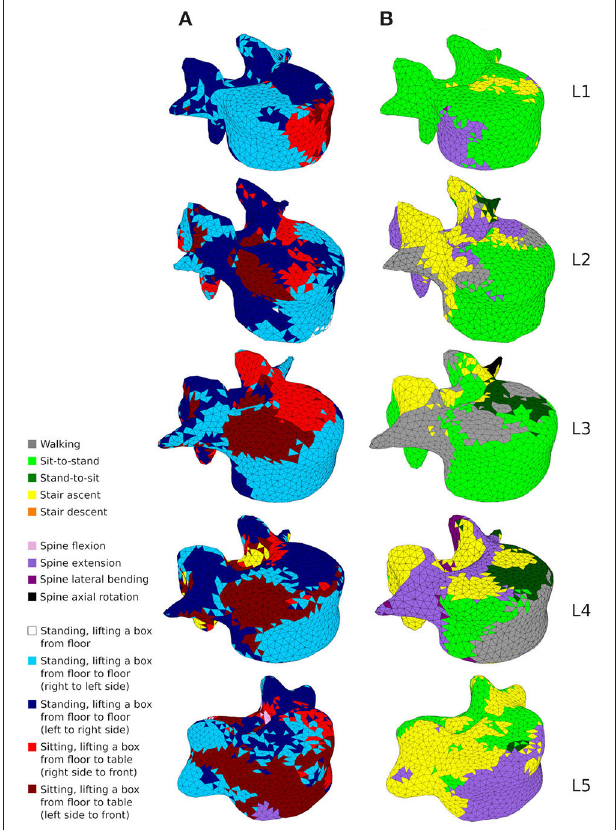
FIGURE 9 | A map showing which activity gives rise to the highest absolute maximum principal strain for the adaptation of the cortical shell elements in the healthy scenario (A) and the sedentary scenario (B)